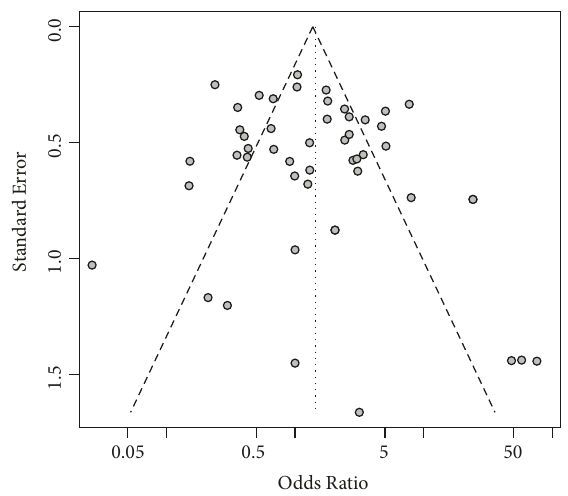
Figure5:Funnelplotforpublicationbias;distributionofdatapoints in funnel plot did not show apparent